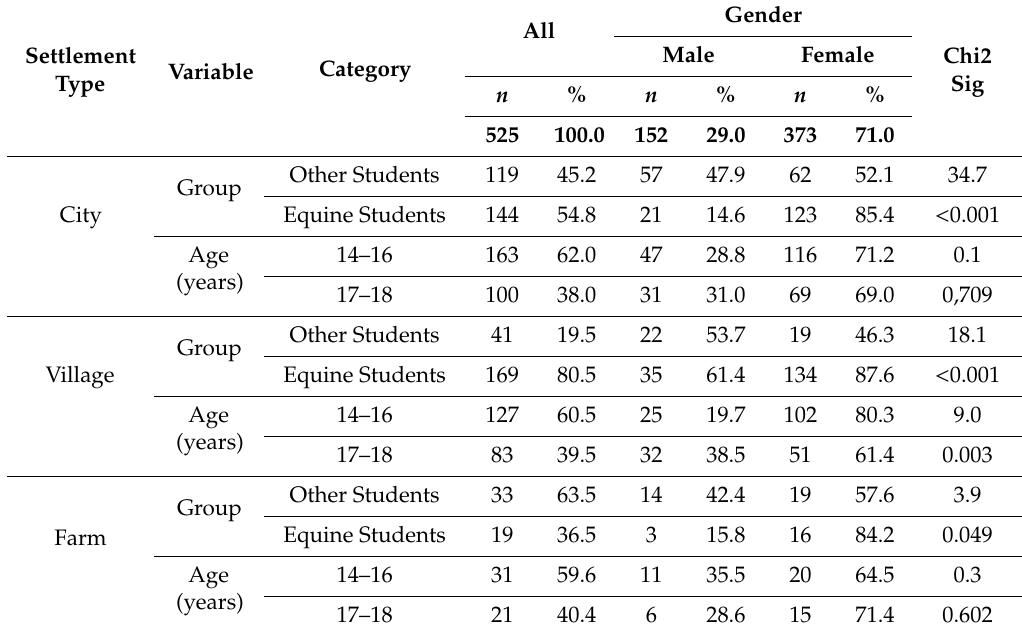
Table 1. Characteristics by gender and settlement type.